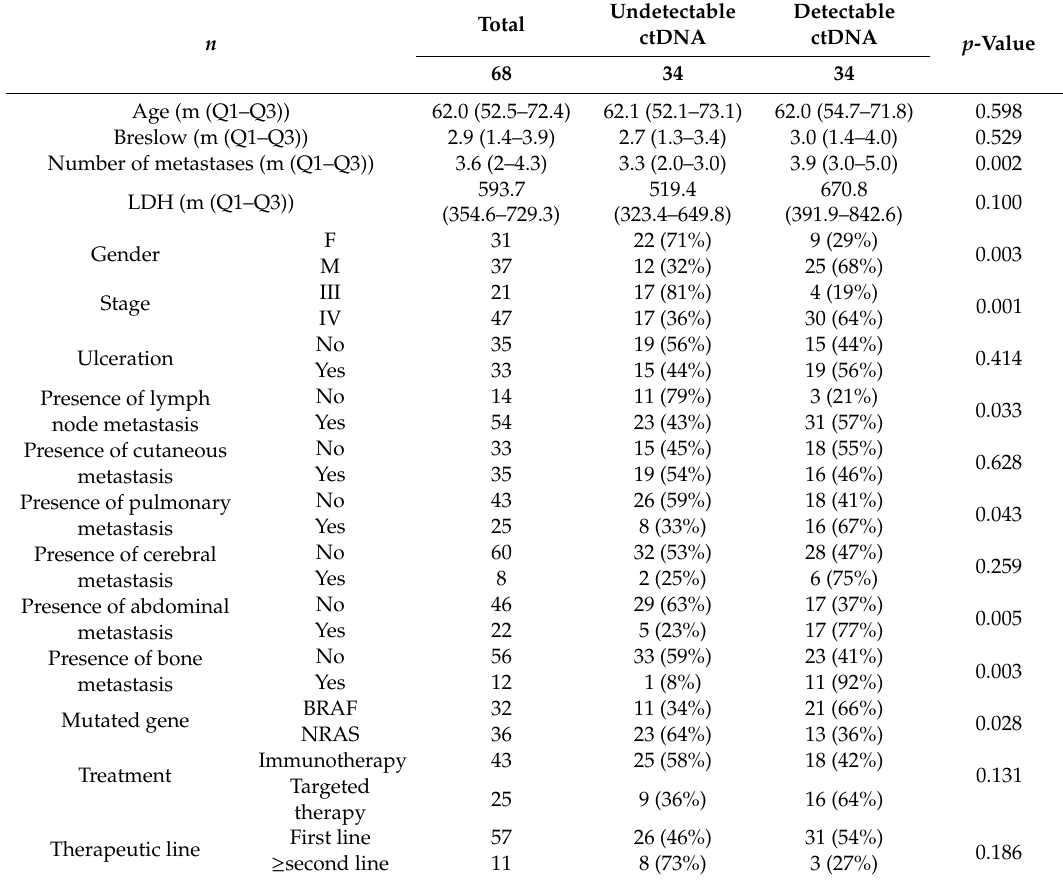
Table 2. Patient characteristics, according to ctDNA detectability in Cobas analysis.